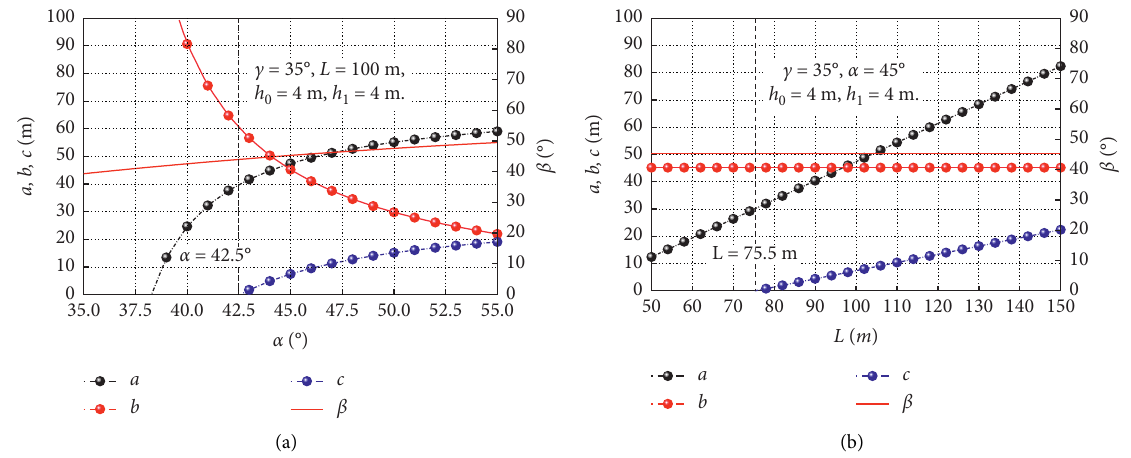
Figure 6: Factors influencing gob-filling characteristics. (a) Influence of angle α on filling characteristics. (b) Influence of length L on filling